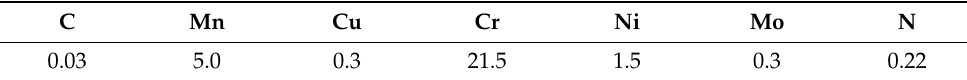
Table 2. Chemical composition (%wt) of the DSS, LDX